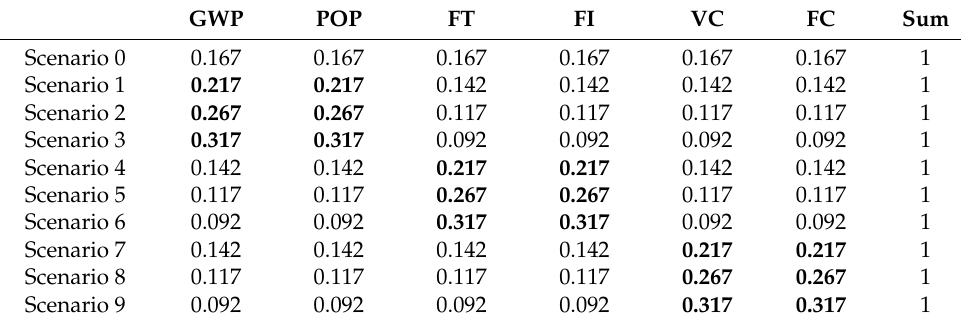
Table 4. Criteria weights assumed for the ten scenarios of the sensitivity analysis.